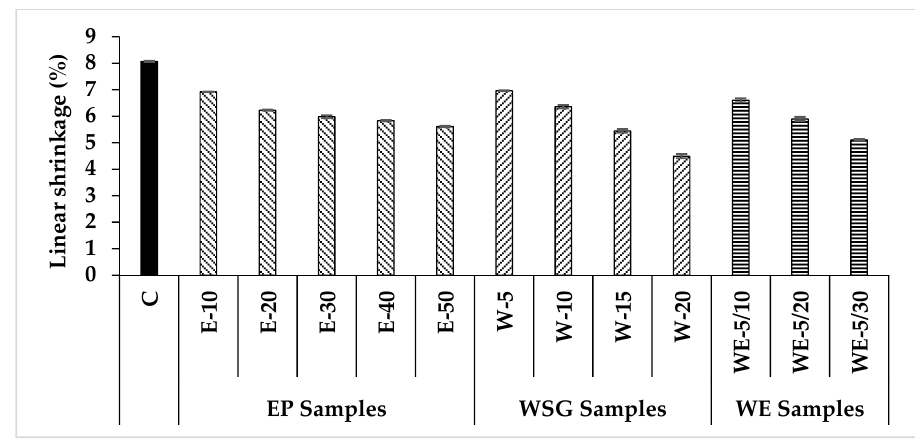
Figure 10. Linear shrinkage results.